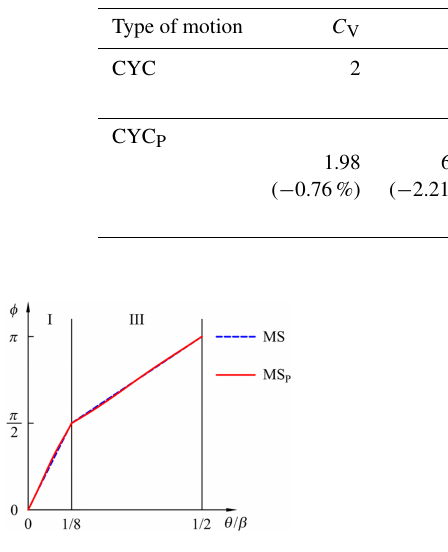
Figure 6. Variation in phase angle function in Example 2.